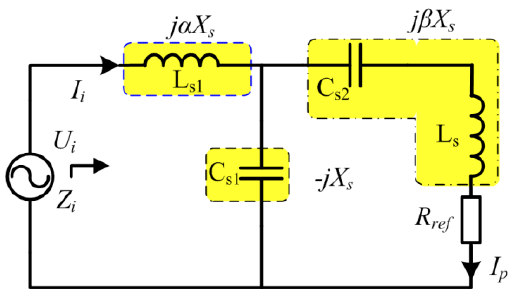
Figure 3. Diagram of the inductor–capacitor–capacitor (LCC) network proposed in [26].